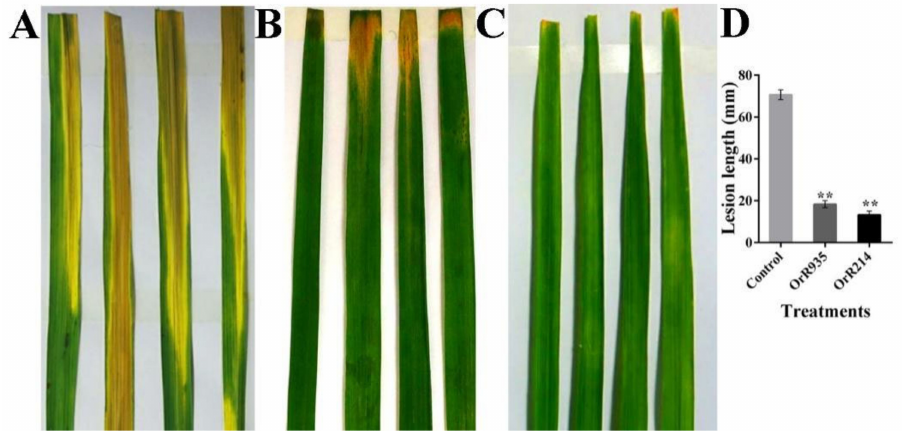
Figure 5. Resistance of rice leaves ( X. oryzae pv. oryzae) treated with antimicrobial peptides. The picture shows symptoms of disease on leaves after 7 d of inoculation. ( A ) B. subtilis SCK6-e (Control), ( B ) OrR935, ( C ) OrR214, and ( D ) the data lesion length of two peptides OrR935 and OrR214 on rice leaves at 7 d post-inoculation. For the mean values, three individual experimental data points were collected. The vertical bars reflect SD, and the data were analyzed GraphPad Prism 6 software. T-tests were conducted for significance analysis at ** p ≤ 0.01.